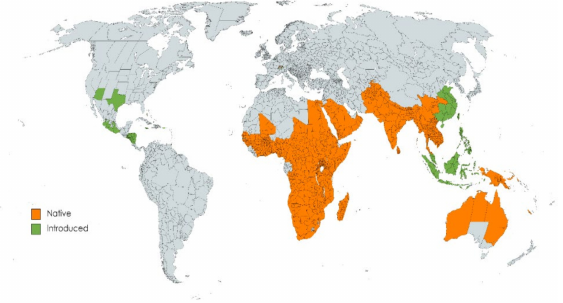
Figure 1. Geographical distribution of Carissa species (Created with